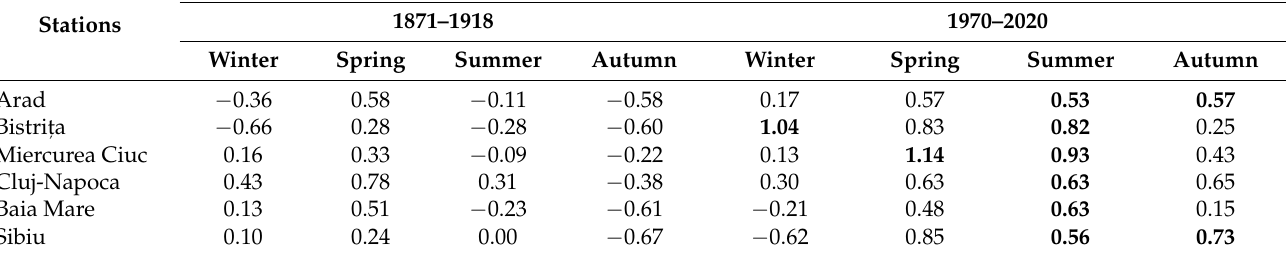
Table 4. Trend ( ◦ C/decade) of daytime minimum and maximum temperature for historical (1871–1918) and current (1971–2020) periods in the Transylvania Region. Bold values indicate signifi- cant changes at the 0.05 significance